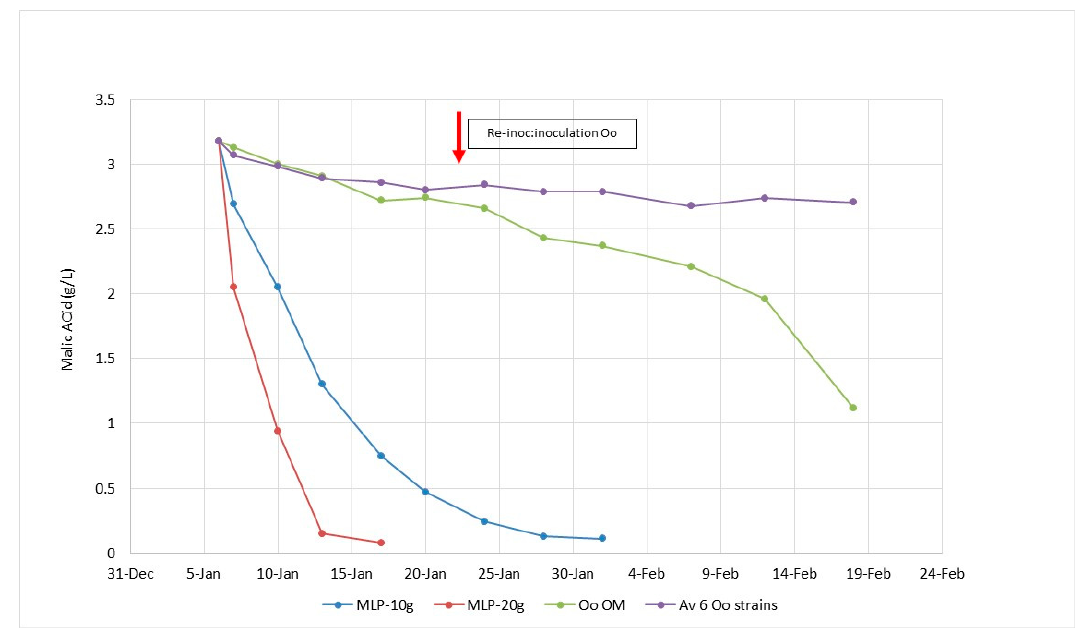
Figure 8. Kinetics of malic acid degradation in a 2019 Chardonnay (Germany) after sequential inoculation with L. plantarum (ML-Prime™), and different O. oeni strains. The kinetics show malic acid degradation with the L. plantarum culture inoculated with a single and double dosage and O. oeni strain Oo OM, and the average of 6 other O. oeni strains inoculated at a single dosage and re-inoculated at a double dosage. Wine analyses before inoculation: malic acid concentration 3.18 g/L, pH 3.21, 13.2% ( v/v ), 55 mg/L total SO 2 (Internal data).